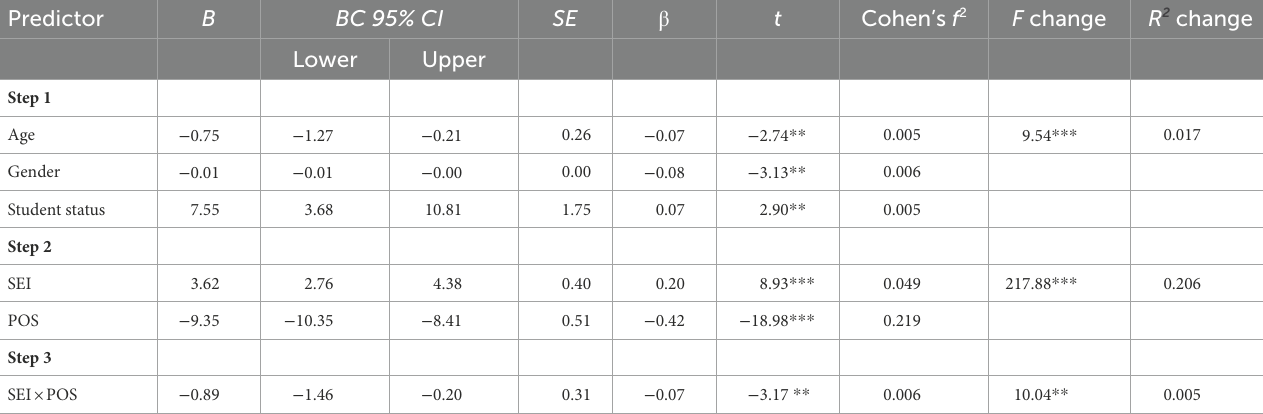
TABLE 6 Multiple regression analyses for the moderating effect of composite positive psychological factors (POS) on the relationship between stress due to social event (SEI) and depression. Predictor